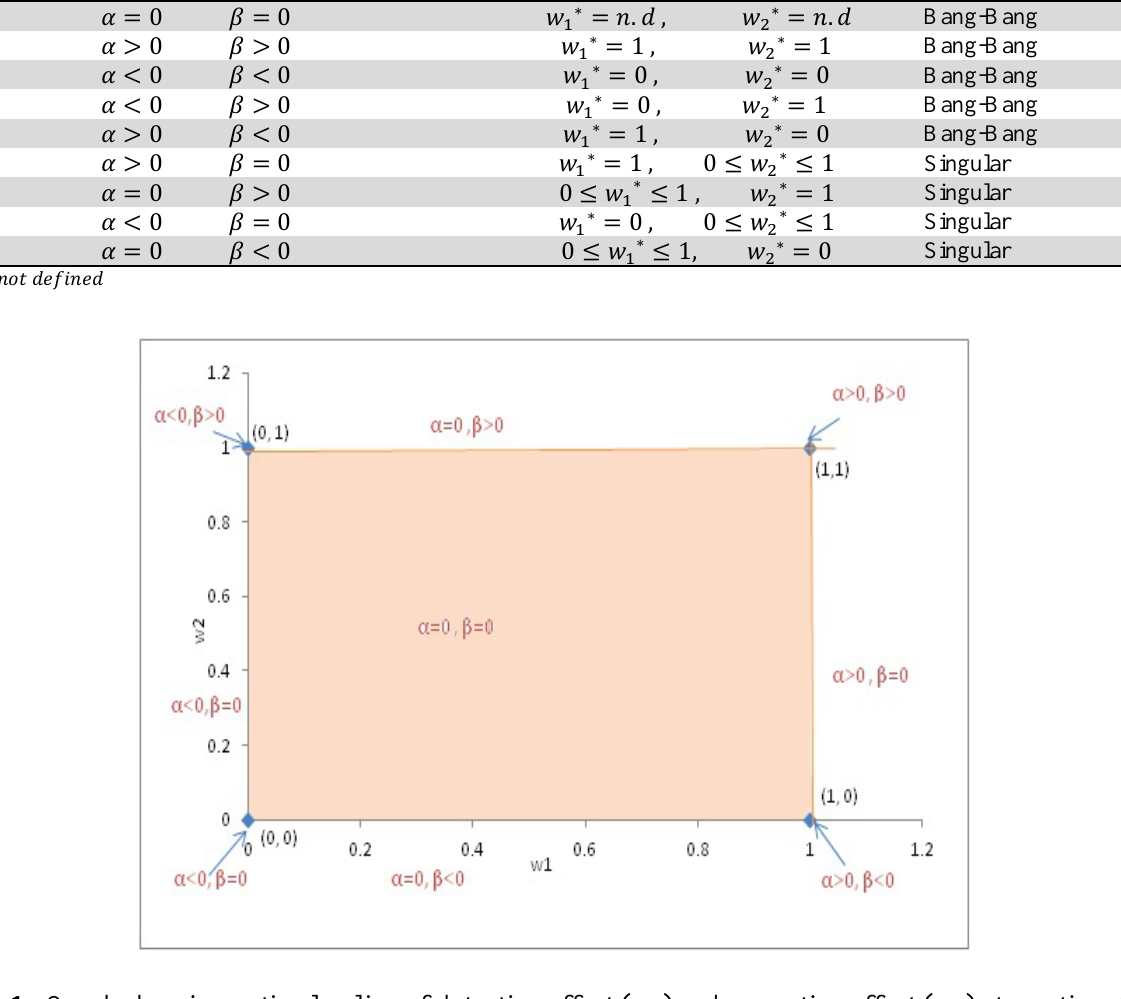
) and correction effort ( 𝑤𝑤 1